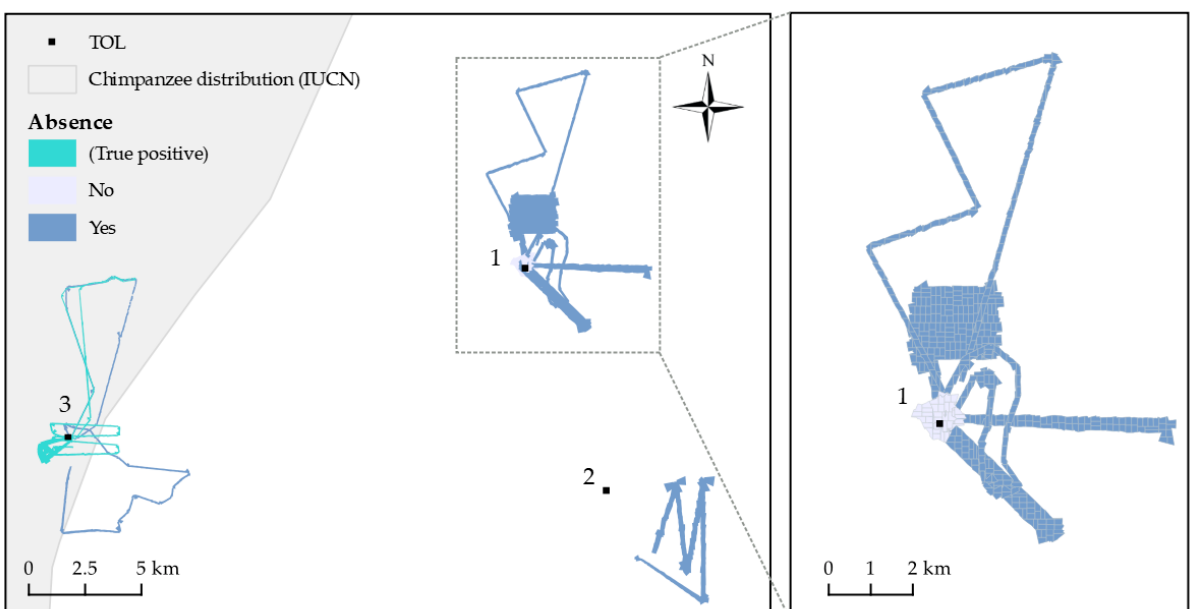
Figure 4. This figure shows the flight paths as well as the nest absence estimates. The right panel is a zoom of TOL 1 to show the plots a flight was divided into for the analyses.